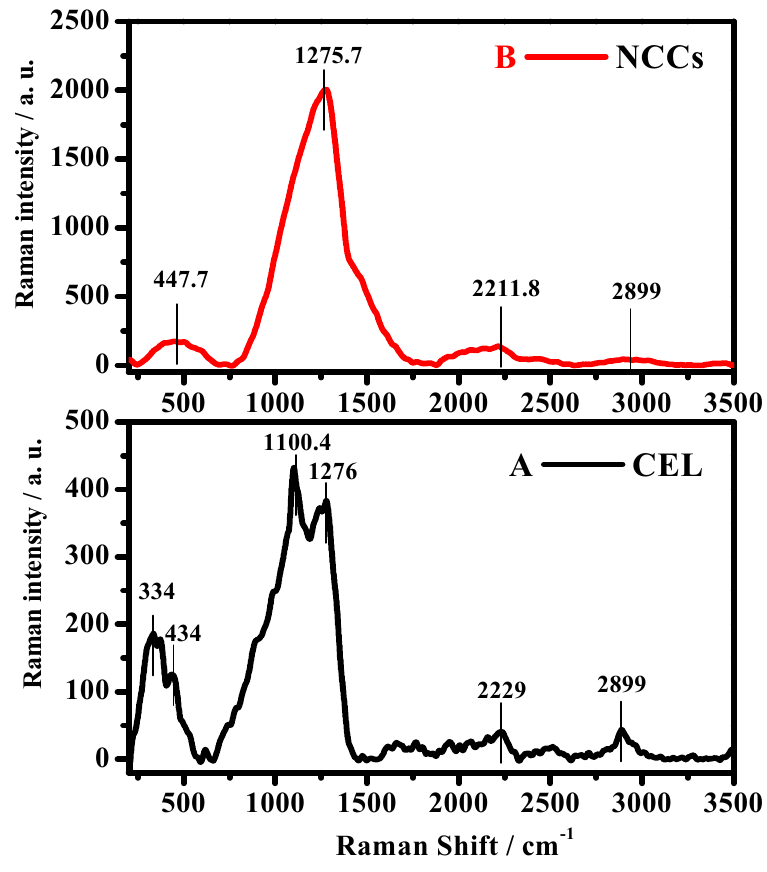
Figure 3. Raman spectra of ( A ) CEL and ( B ) NCC.